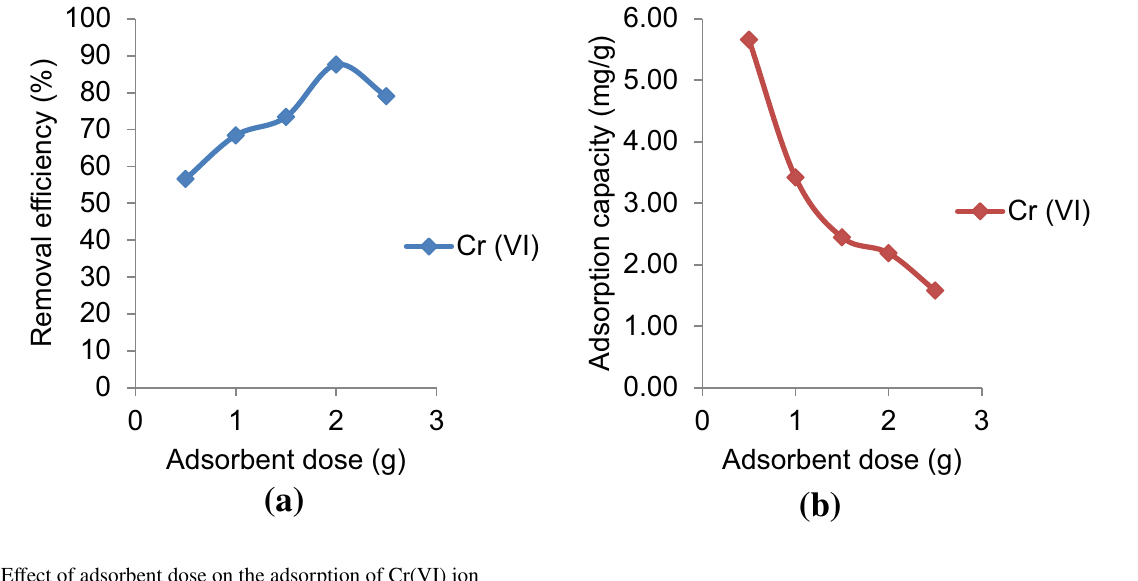
Fig. 4 Effect of adsorbent dose on the adsorption of Cr(VI)